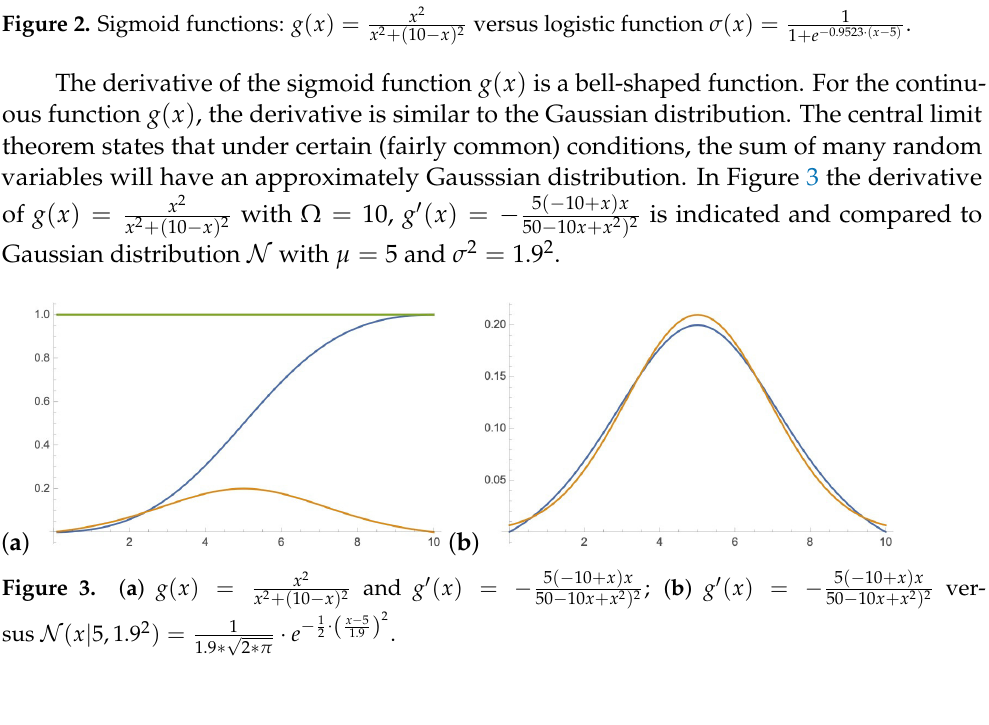
Figure 2. Sigmoid functions: g ( x ) = x 2